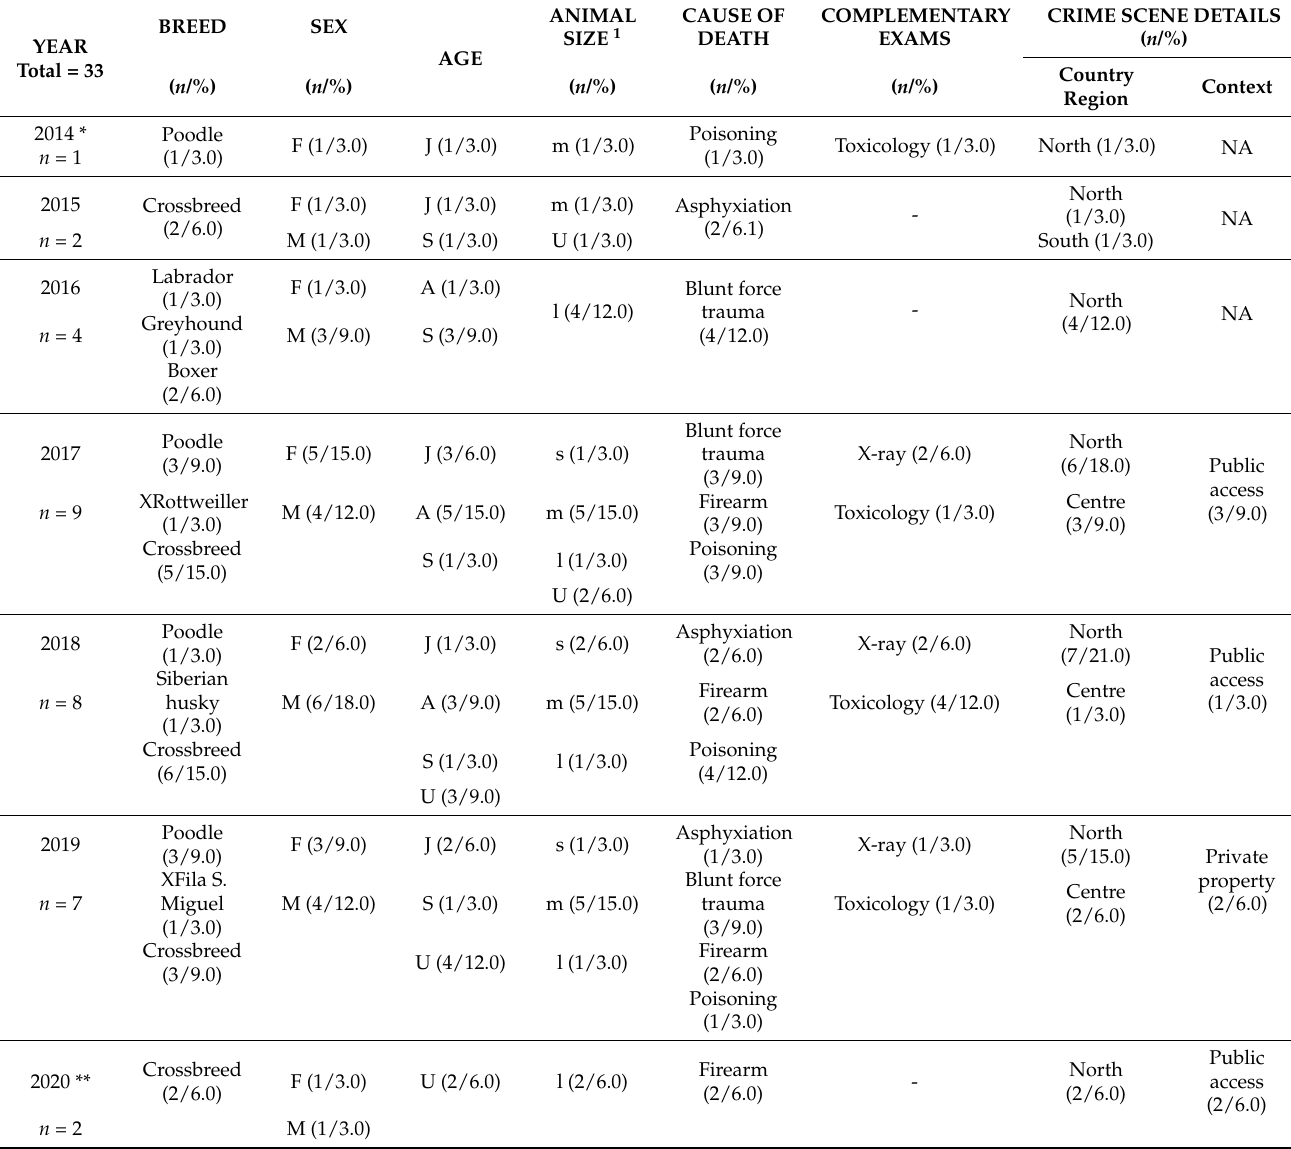
Table 1. Characterization of the canine cases of violent death confirmed through forensic